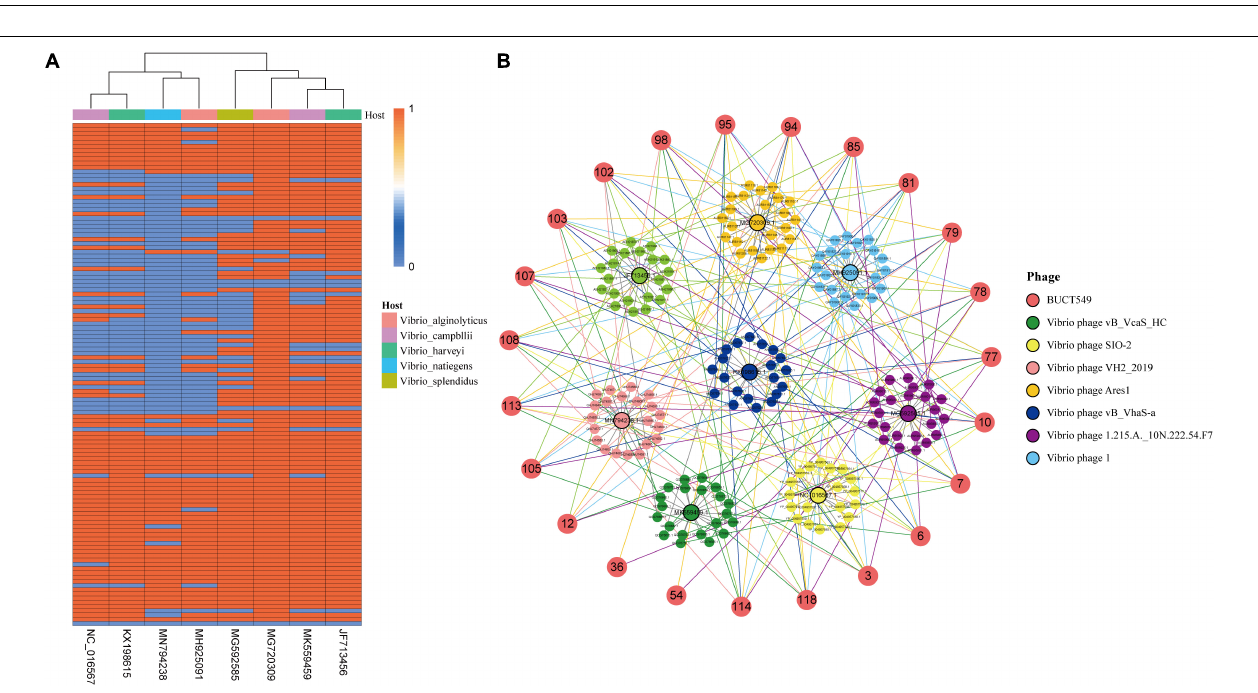
FIGURE 9 | Analysis of genes shared by BUCT549 with other Vibrio phages. (A) The heat map shows the different Vibrio phage genes compare to BUCT549 with red representing phage sharing the gene with BUCT549 and blue representing not sharing the gene. Phage host species are colored above the heat map. (B) Relationship between the annotated genes of BUCT549 and other phage genes, the connecting lines represent the gene shared by phages.